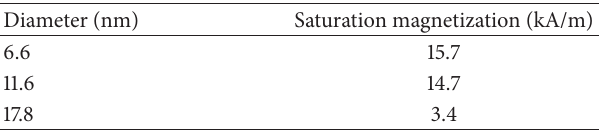
Table 1: Saturation magnetization ( 𝑀 𝑠 ) of the oleate-capped Fe nanoparticles with different diameters at 300